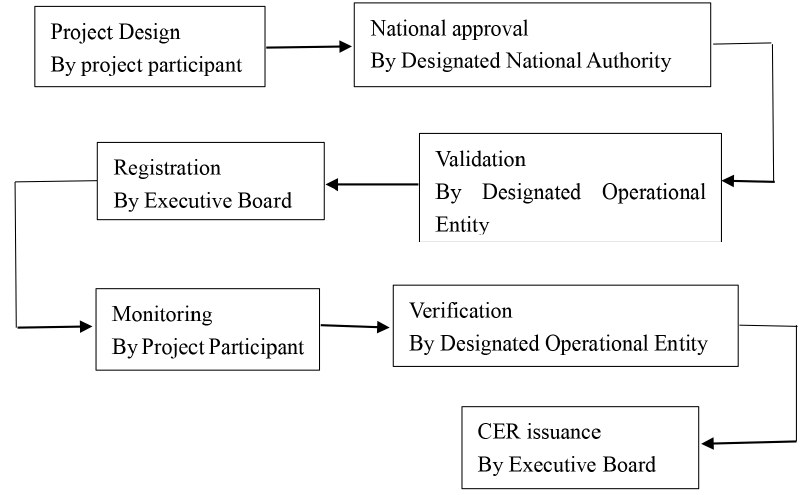
Figure 3. The Clean Development Mechanism (CDM) project cycle [21]. CER: Certified Emission Reduction.